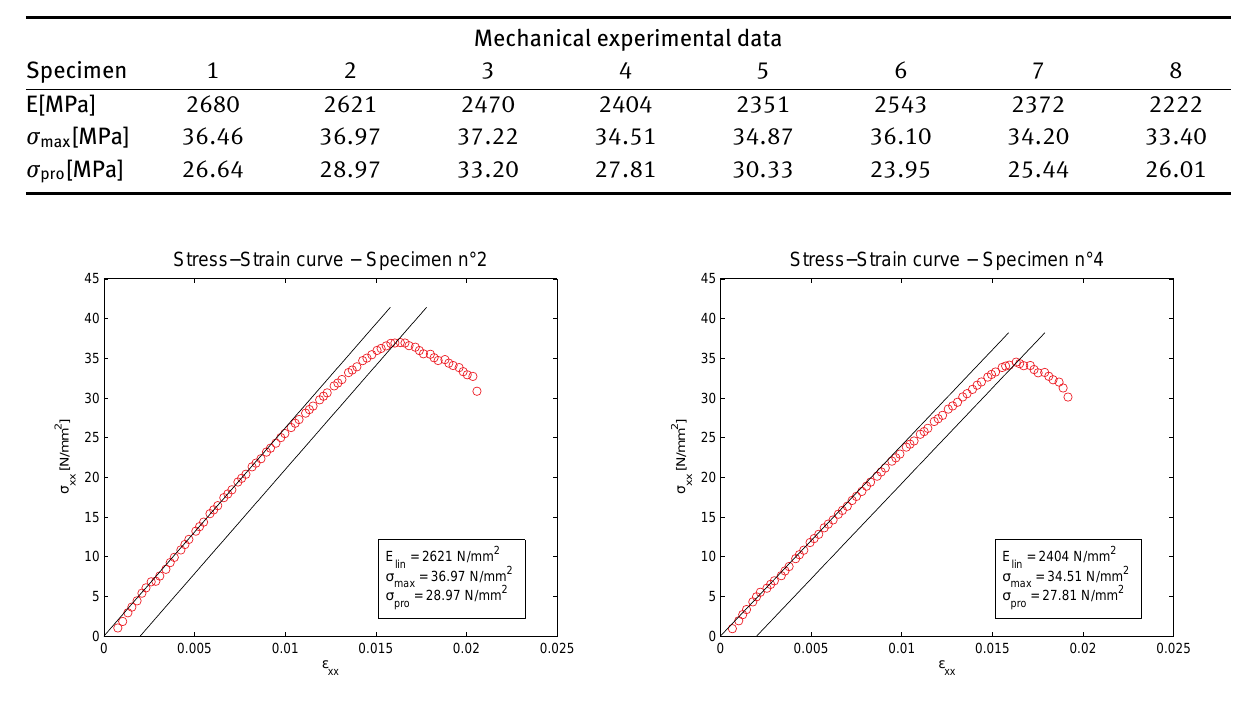
Figure 12: Actual stress-strain curve for specimen 2.